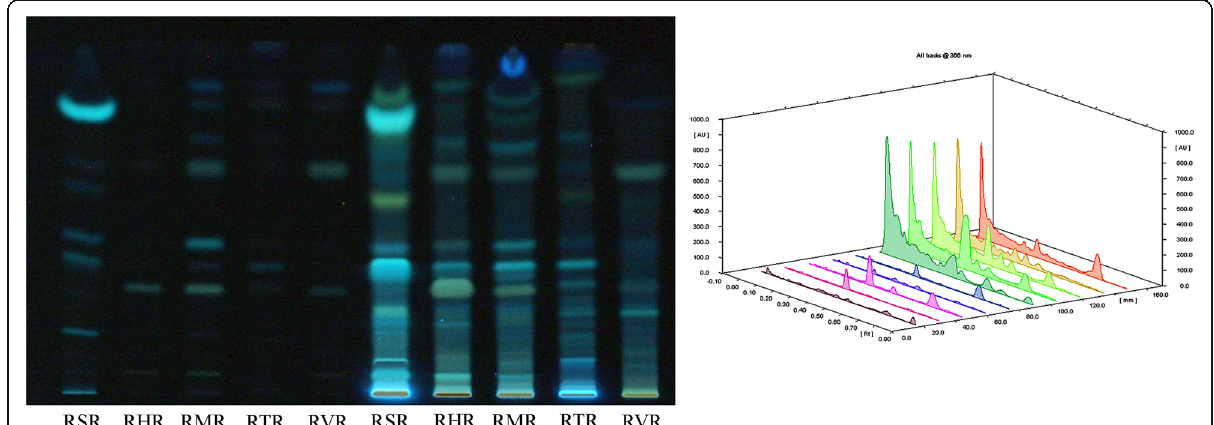
Fig. 1 HPTLC profile of sequential n-hexane and chloroform extracts of various Rauvolfia species. Tracks: 1-5, n-hexane extracts; 6-10 chloroform extracts: RSR: R. serpentina root, RHR: R. hookeri root, RMR: R. micrantha root, RTR: R. tetraphylla root, RVR: R. verticillata